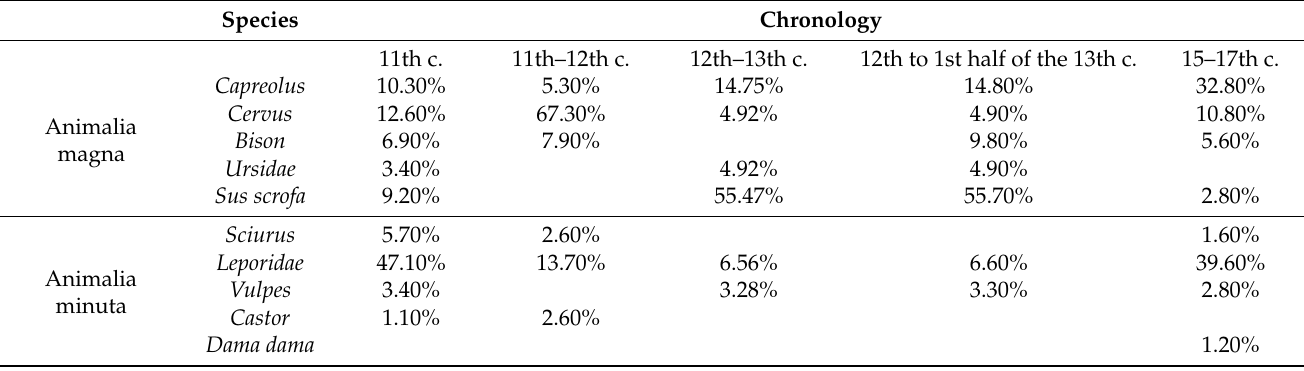
Table 4. Percentage of wild animals from Ostr ó w Tumski (Cathedral Island) with distinction between animalia magna and animalia minuta over the centuries [29,30] (Description: M. Pietruszka).